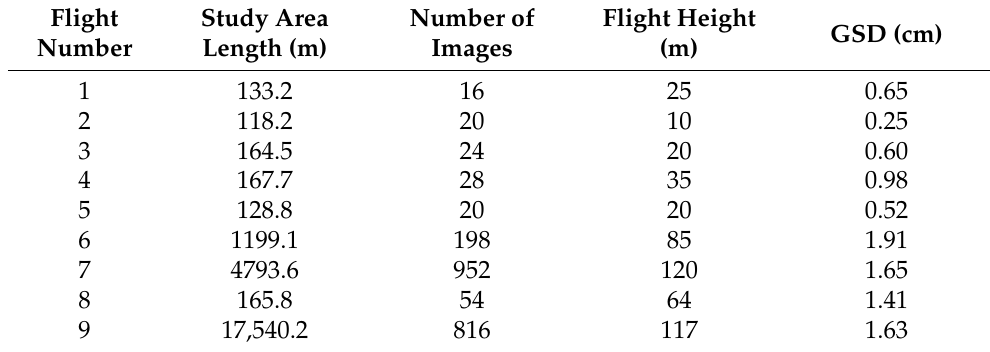
Table 5. UAS Flight